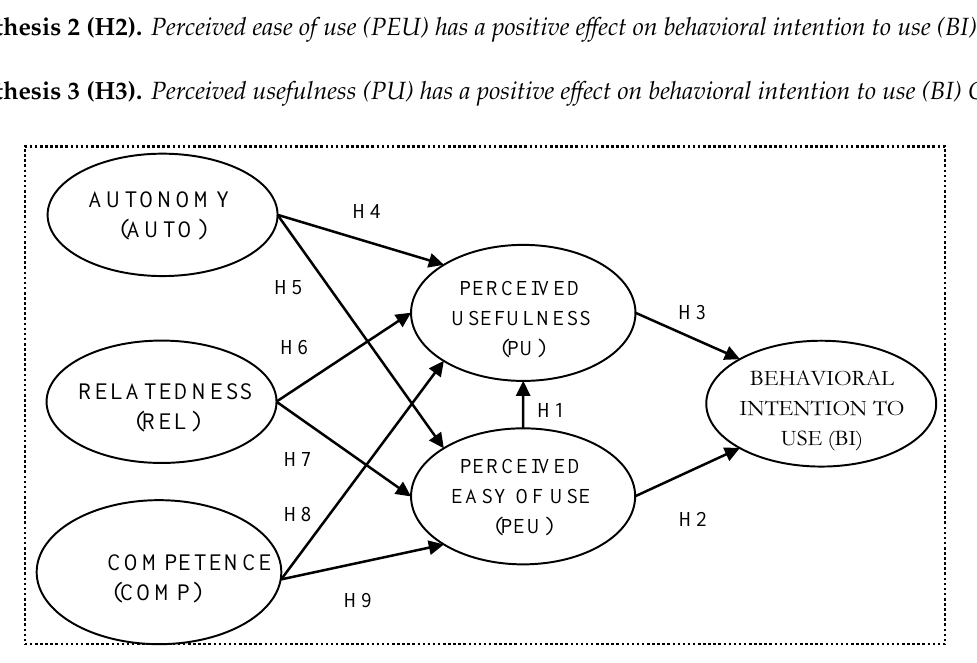
Figure 2. Research model.